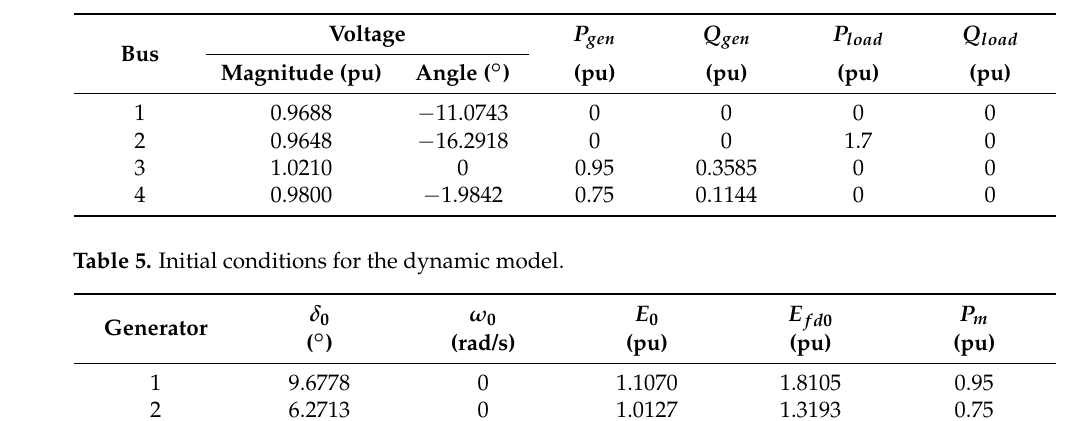
Table 4. Power flow solution for a topology of Figure 2.